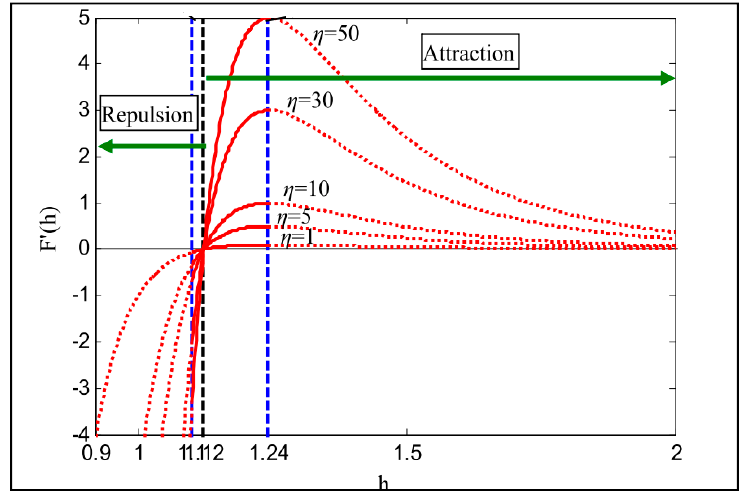
Figure 12. The behavior of the interaction force function with the scaled distance ( h ) under di ff erent depth values [34].